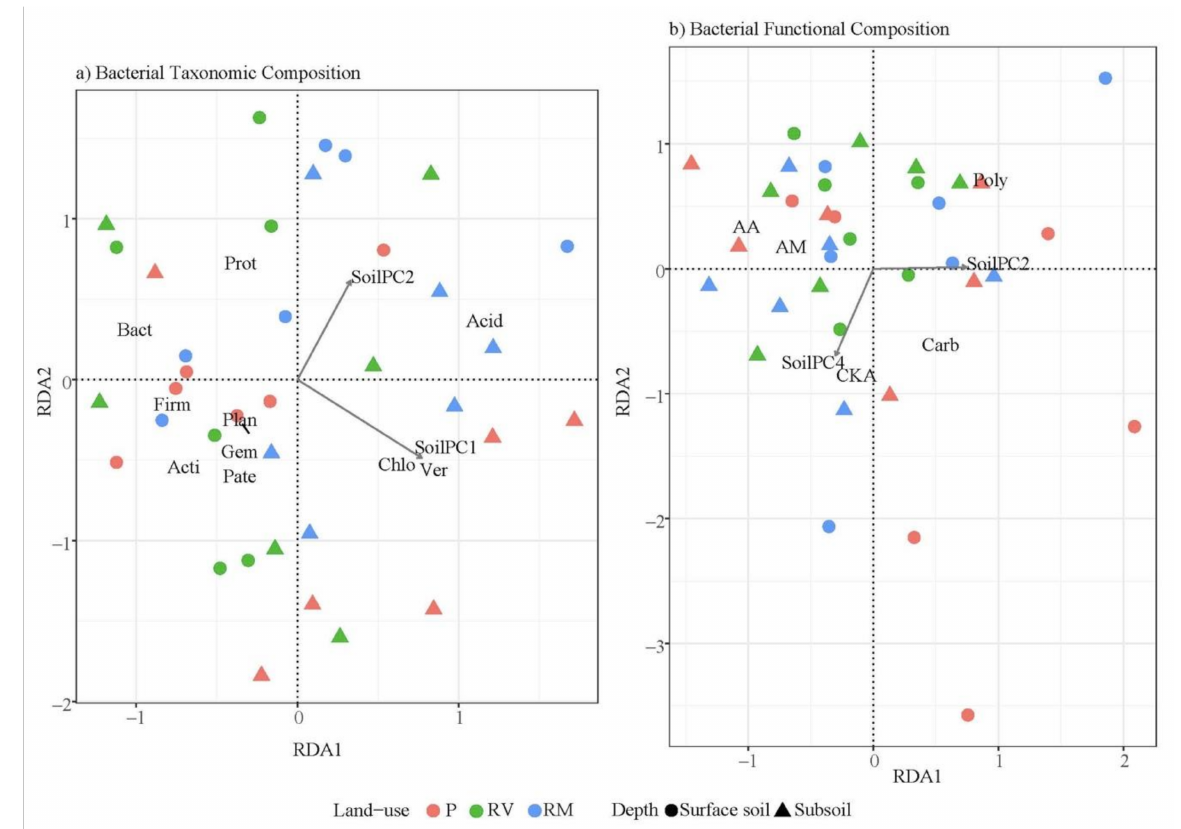
Figure 6. Redundancy analysis using environmental variables from PCA dimensions as seen in Figure 1 and Supplementary Figures S1 and S2 to explain variation in ( a ) bacterial taxonomic composition by phyla and direction of constraints from principal components, ( b ) bacterial functional composition showing the direction of constraints from principal components (CLPP—represented as AWCD). Points are colored based on land use (red = pasture (P), green = revegetated (RV), and blue = remnant (RM)) with symbols distinguishing soil depth (circle = surface soil and triangle = subsoil). Only significant environmental variables are shown. Bacterial taxonomic composition had a p value of <0.00 and R 2 of 0.42, and bacterial functional composition had a p value of 0.01 and R 2 of 0.17. Names for phyla have been abbreviated in Figure 6a; abbreviations are as follows: Proteobacteria (Prot), Actinobacteria (Acti), Acidobacteria (Acid), Planctomycetes (Plan), Chloroflexi (Chlo), Firmicutes (Firm), Bacteroidetes (Bact), Verrucomicrobia (Ver), Gemmatimonadetes (Gem), and Patescibacteria (Pate). Names for carbon guilds have been abbreviated in Figure 6b; abbreviations are as follows: Amines and amides (AM), amino acids (AA), carbohydrates (Carb), carboxylic and ketonic acids (CKA), and polymers